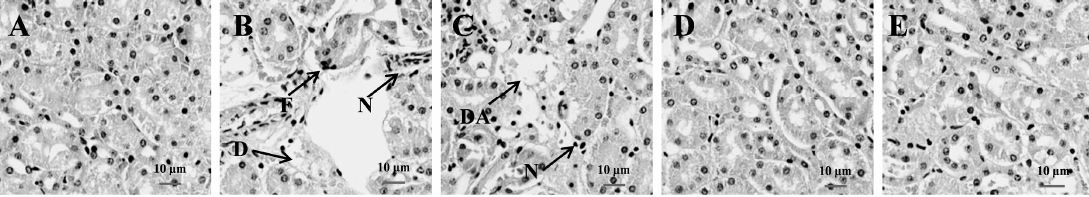
Figure 3. Photomicrograph of spleen from each experimental group (magnification = 100×). ( A ), control group, normal diet, showing the absence of damage of spleen tissue; Compared with the control, the CYP group ( B ) showed evident necrosis region (N), cellular fibrosis (F) and disordered arrangement of cells (DA). In the CV (6%) group ( C ), the necrosis region became minor and the intercellular space was lessened as compared with the CYP group. The CV (12%) group ( D ) and CV (24%) group ( E ) had unbroken cell, and fibrosis cells became smaller.